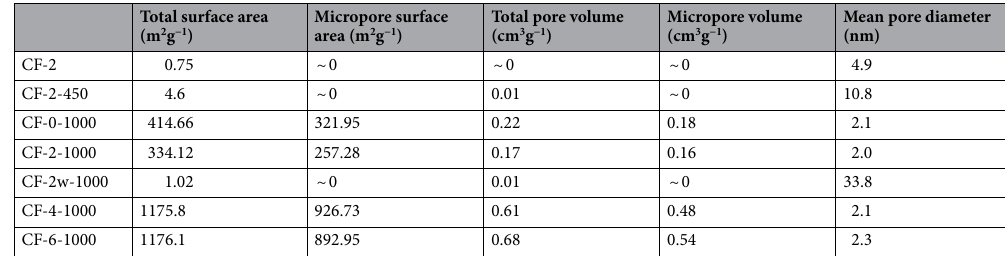
Table 1. Surface characteristics of the synthesized carbon foams which have been extracted from the adsorption–desorption